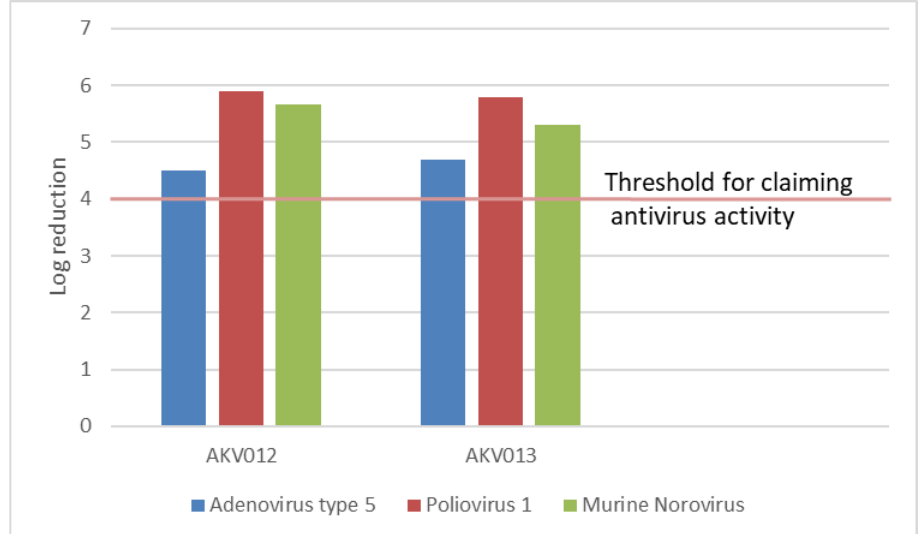
Figure 7. Log reduction of three virus strains by AKVANO skin disinfectant formulations AKV012 and AKV013. Calculations are based on the proportion of ten replicates showing cytopathic effects at a certain dilution level.